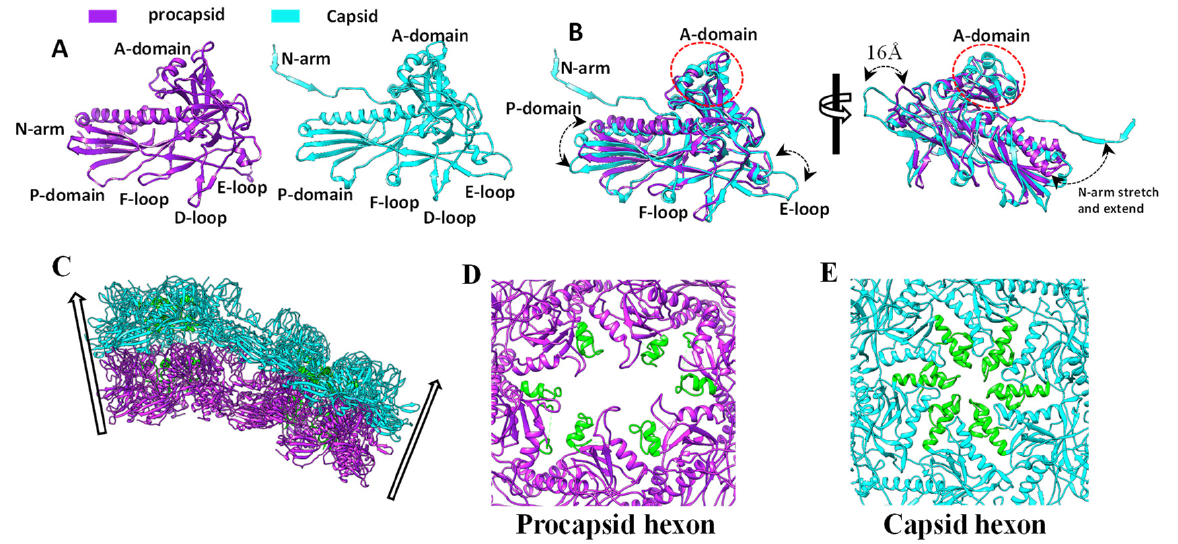
Figure 4. The conformational transition of the coat protein from the procapsid to the capsid. ( A ) Gp5 subunits of penton in the procapsid (left) and the capsid (right) . ( B ) The superposition of the coat protein subunit of the procapsid and capsid shows the conformational change during the expansion of the capsid. ( C ) A side view of the models of a hexon and a penton in the procapsid (purple) and the capsid (cyan) shows the capsid expansion. ( D ) The central opening of the hexamer of the procapsid. ( E ) The central opening of the hexamer of the capsid. The conformational change in the A-domain tip is colored in green.